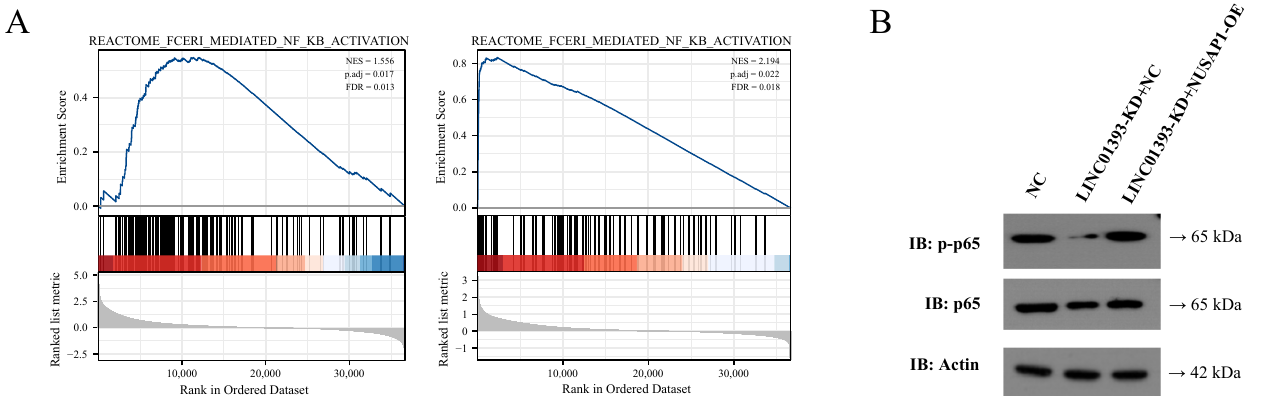
Figure 7. LINC01393 and NUSAP1 promotes NF- κ B pathway. ( A ) GSEA of LINC01393 and NUSAP1 reveal an enrichment of NF- κ B pathway. ( B ) Western blot of phospho-NF- κ B-p65 and NF- κ B-p65 in U87 cells following transfection with normal control, LINC01393-KD+NC, and